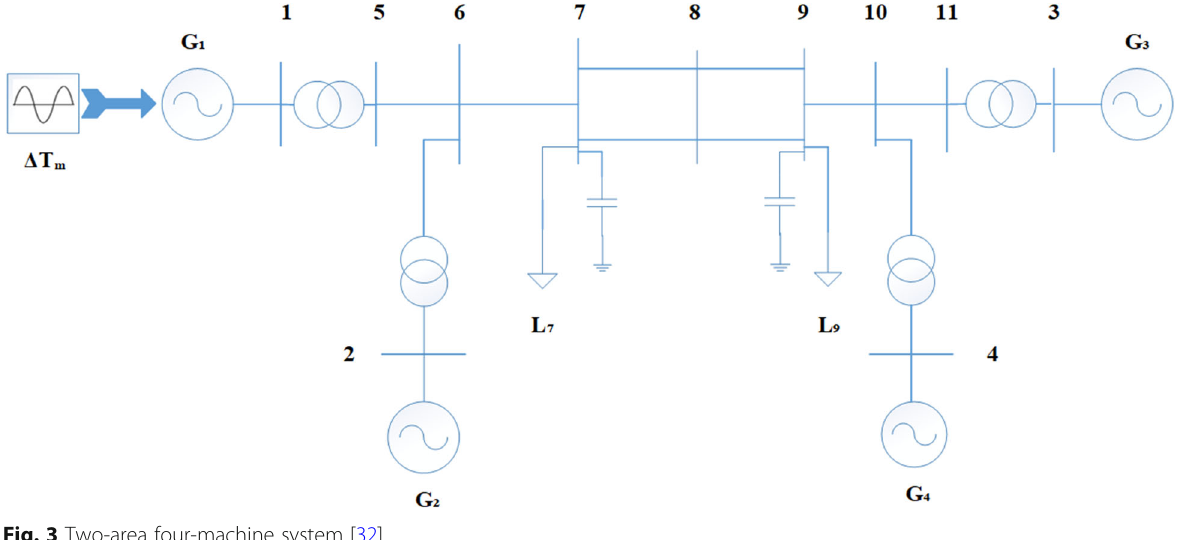
Fig. 3 Two-area four-machine system [32]